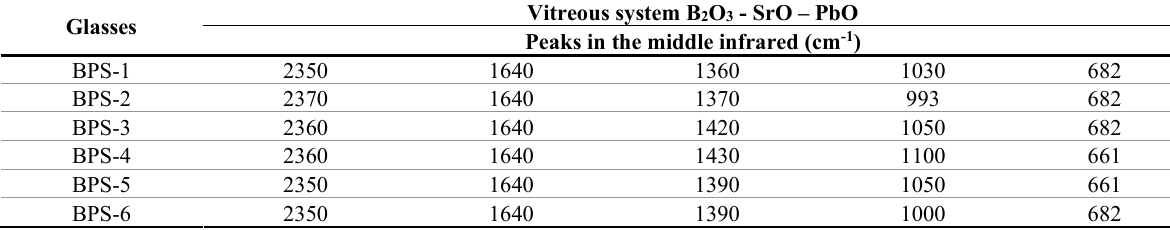
Table 4 position of the peaks for the FTIR spectra of the vitreous systems. Glasses